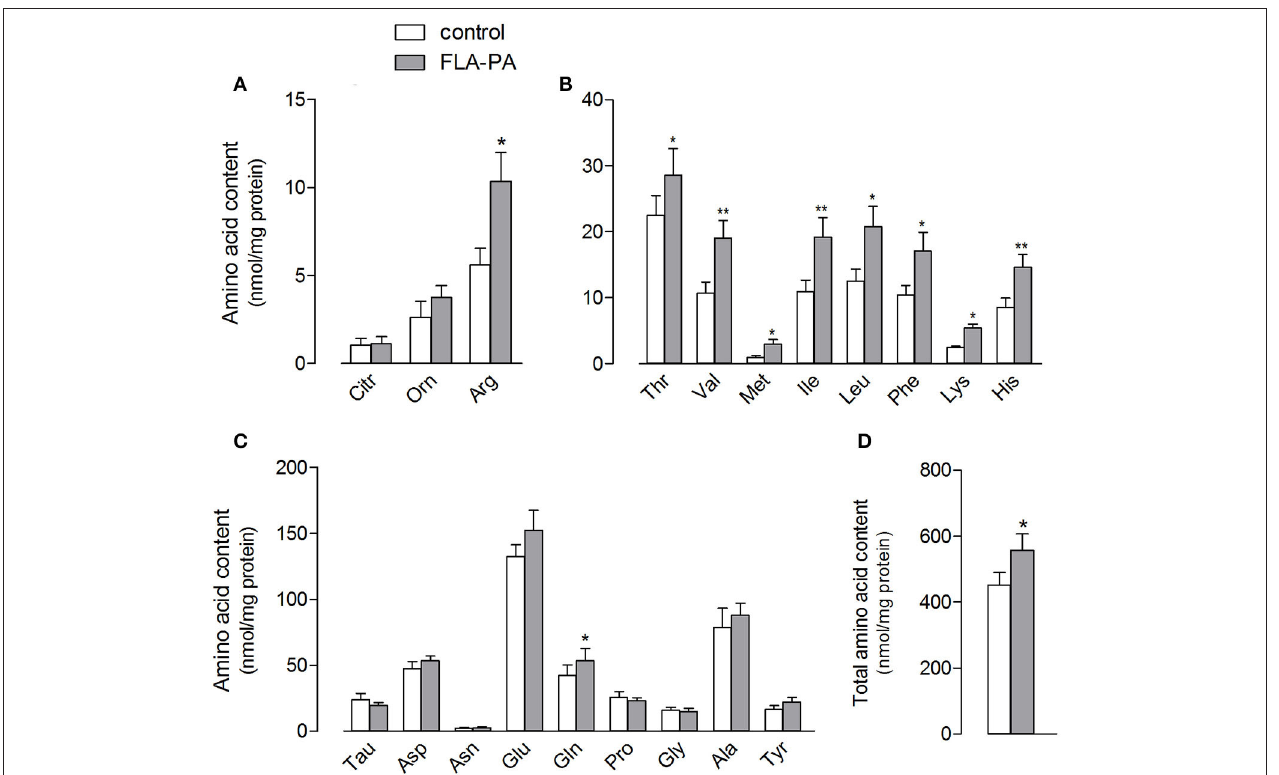
FIGURE 4 | Calu-3 cells were treated for 24h with 2 µ g/ml FLA-PA and the intracellular content of arginine and its metabolites (A) , essential (B) , and non-essential (C) amino acids was determined as described in section “Materials and methods”. Total amino acid content is also shown (D) . Bars represent the mean ± SEM of four independent experiments. * p < 0.05, ** p < 0.01 vs.